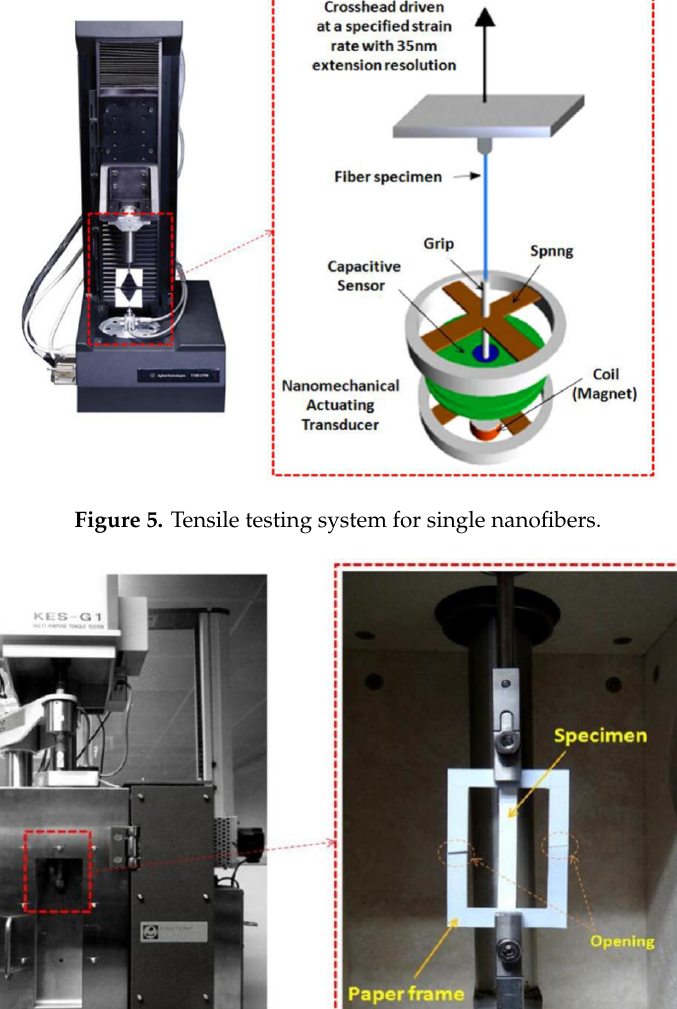
Figure 6. Tensile testing system for nanofibrous membranes.